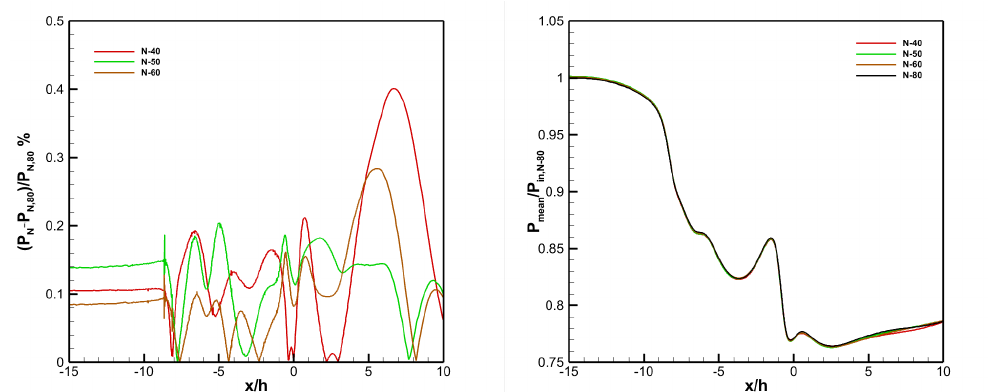
Figure 6. Local error analysis of the mean pressure along the centerline based on the finest (N-80) mesh. The mean pressure is normalized by the inlet mean pressure P in = 128,961.46 Pa.